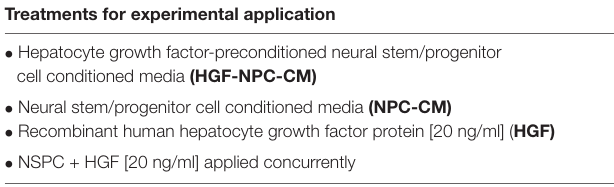
TABLE 1 | List of treatments for experimental